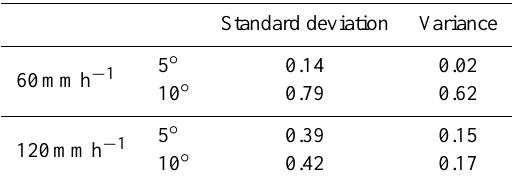
Table 2. Spatial variability in the ratios of 5 β : 5 α -stanols in soil cores across the slope for each experiment (excluding samples taken in the slurry application